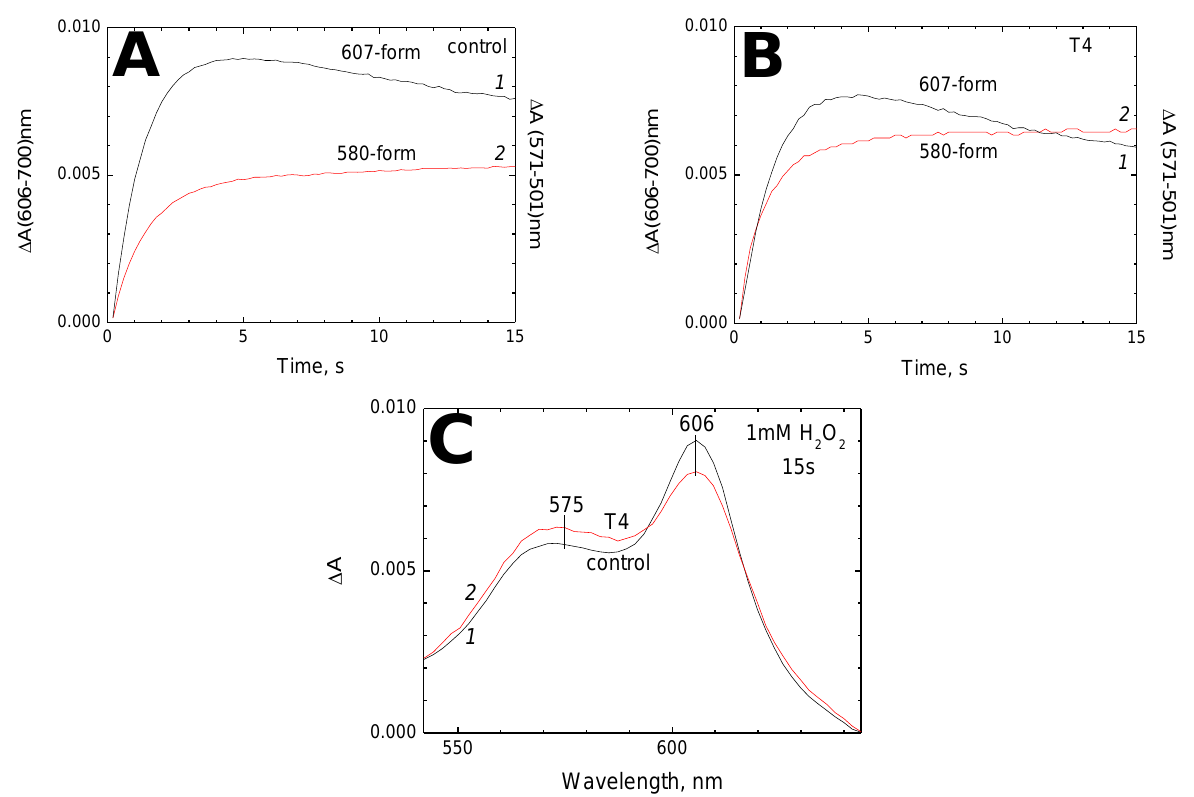
Figure 6. Effect of T4 on the formation of CcO oxoferryl intermediates during the reaction with H 2 O 2 . The reaction was followed using a diode array spectrophotometer. Final concentrations after mixing: 3.25 µ M CcO, 1 mM H 2 O 2 , 0.5 mM T4. ( A , B ) Kinetics of the oxoferryl intermediates’ formation. Spectral forms F I -607 (trace 1 , black) and F II -580 (trace 2 , red) are followed by the absorption differences at 606–700 nm and 571–501 nm, respectively. ( A ) Control; ( B ) CcO was pre-incubated with 0.5 mM T4 until mixing. ( C ) Difference spectra (15 s vs. 0.2 s after mixing) obtained in the absence (control spectrum 1 , black) and presence (spectrum 2 , red) of 0.5 mM T4. Panels ( A ) (control) and ( B ) (experiment in the presence of T4) show kinetic traces of F I -607 and F II -580 formation. In the presence of T4, F I -607 forms slightly slower (t 1/2 ≈ 0.99 s vs. 0.91 s) and its yield is lower than in the control ( cf. black curve 1 in panels ( A , B )), whereas the formation of F II -580 is accelerated by 23% (t 1/2 ≈ 0.85 s vs. 1.1 s) and the yield is higher than in the control ( cf. red curve 2 in panels ( A , B )). Figure 6C shows the difference absorption spectra of the control sample (spectrum 1 ) and the sample treated with T4 (spectrum 2 ) obtained 15 s after mixing, when the observed difference looks most valid. As seen, in the presence of T4, the concentration of F I -607 is lower and F II -580 higher than in the control, though the deviation is only about 10%. Accordingly, the overall decrease of the ratio [F I -607]/[F II -580] is about 20%, exactly as in the titration experiments (see